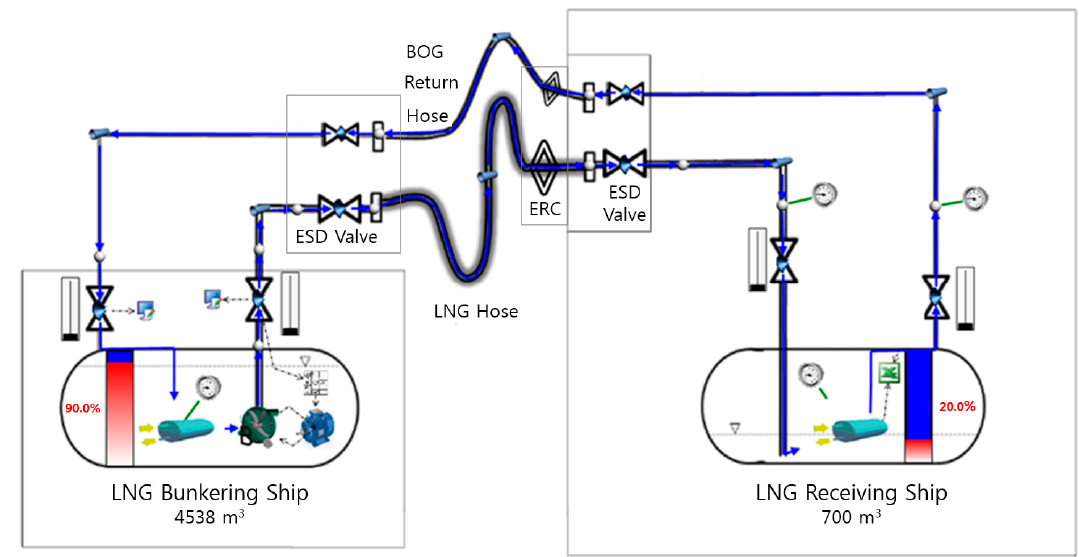
Figure 2. Simplified process flow diagram of the ship-to-ship LNG bunkering scenario (Begin Bunkering).